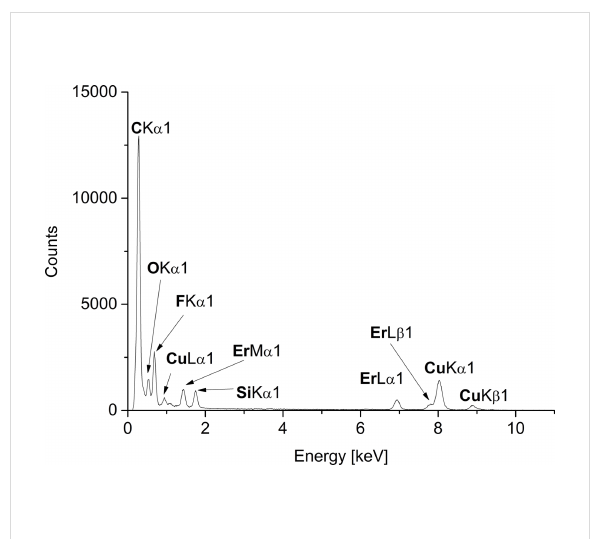
Figure 3: EDX of 1.0 wt % ErF 3 -NPs in [BMIm][BF 4 ] from Er(amd) 3